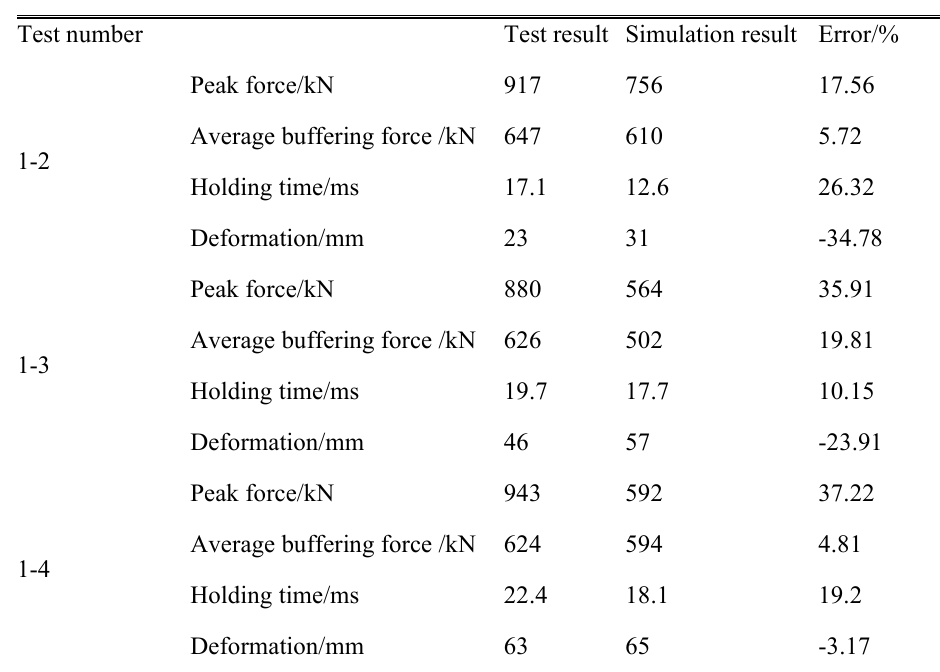
Table 4. J-C simulation and test comparison.